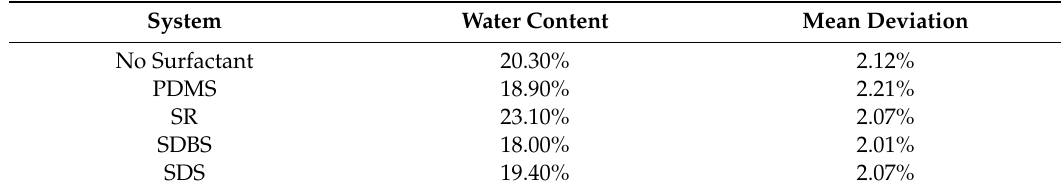
Table 7. Rate of water content of phosphogypsum after the modification of the compound surfactants.